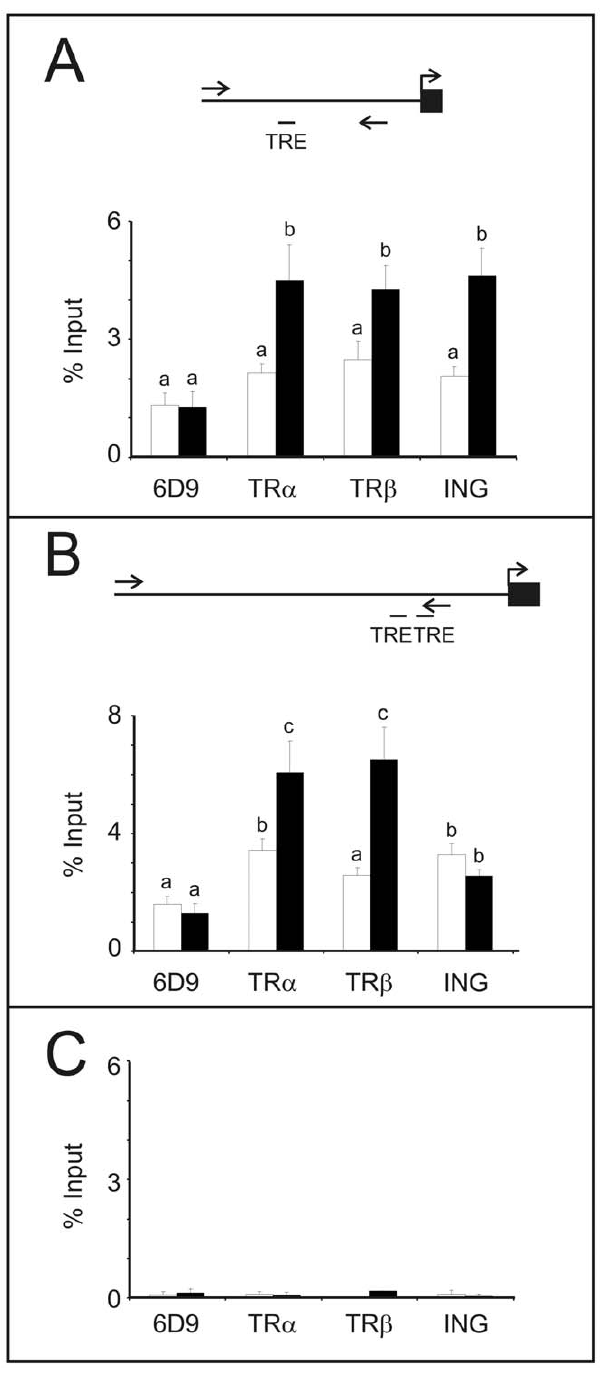
Figure 5. Chromatin immunoprecipitation assays indicate that ING protein associates with the TR b and TH/bZIP promoters that are known to be T 3 -regulated in tadpole tails. The promoter regions amplified upon ChIP are indicated by the arrows in the cartoons above the graphs for A) TR b and B) TH/bZIP promoters and C) a b -actin gene control. The graphs show the percent input values of the amplicons obtained after immunoprecipitation with the indicated antibodies directed against TR a , TR b , ING, and a control antibody, 6D9. DNA-protein complexes were obtained from pools of 7–12 tails from tadpoles NF stage 52–54 that were either time-matched solvent controls (white bars) or treated with 10 nM T 3 for 48 h (black bars). Independent sets of animals were tested and averaged (n=3–6, TR b promoter; n=3–5, TH/bZIP promoter). The error bars represent the